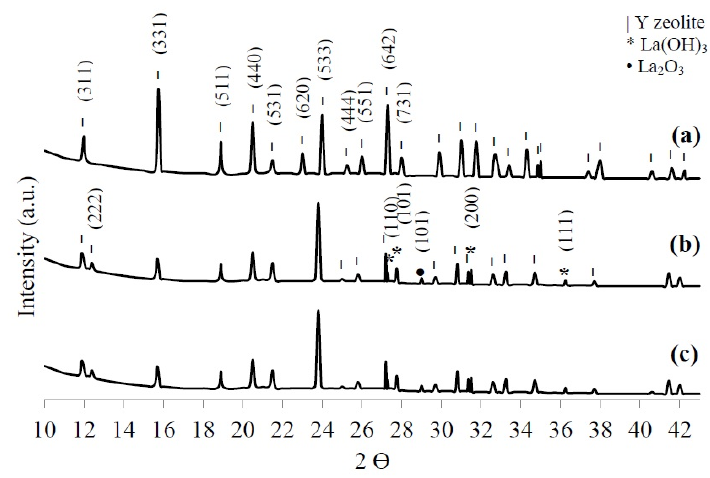
Figure 4. X-ray diffraction (XRD) patterns of ( a ) HY zeolite, ( b ) LaY and ( c ) Pd/LaY catalysts.